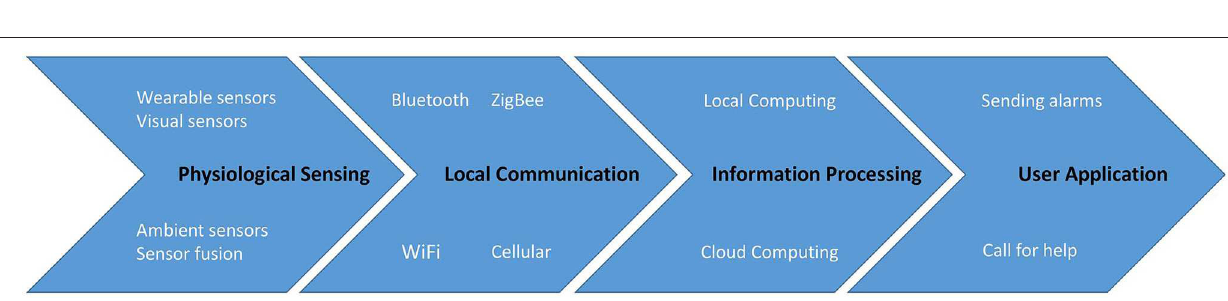
FIGURE 3 | Illustration of the literature search strategy. The wearable-based queries in Table 2 return 28 articles. The vision- and ambient-based queries return 31 articles, and the sensor fusion queries return 28 articles.